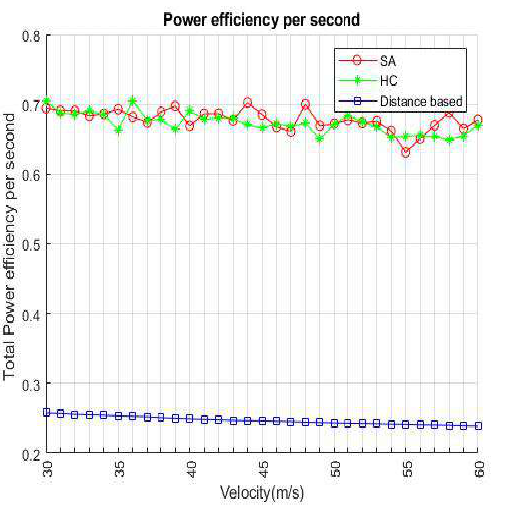
Figure 9. Power efficiency per